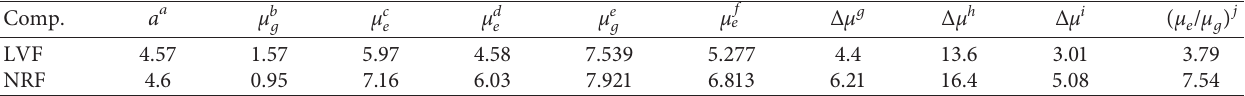
Figure 5: Plot of ] + ] f ( ε , n ) + 2 g ( n ) using Kawski–Chamma–Viallet equation for (a) LVF in different solvents (chloroform, dichloromethane, isopropanol, ethanol, methanol, distilled water, ethyl acetate, and ethyl glycol) and (b) NRF in different solvents (chloroform, dichloromethane, isopropanol, ethanol, methanol, distilled water, ethyl acetate, and ethyl glycol). Table 4: Calculated value of dipole moments in Debye (D) and Onsager cavity radius (a) obtained from experimental and theoretical work for LVF and NRF.